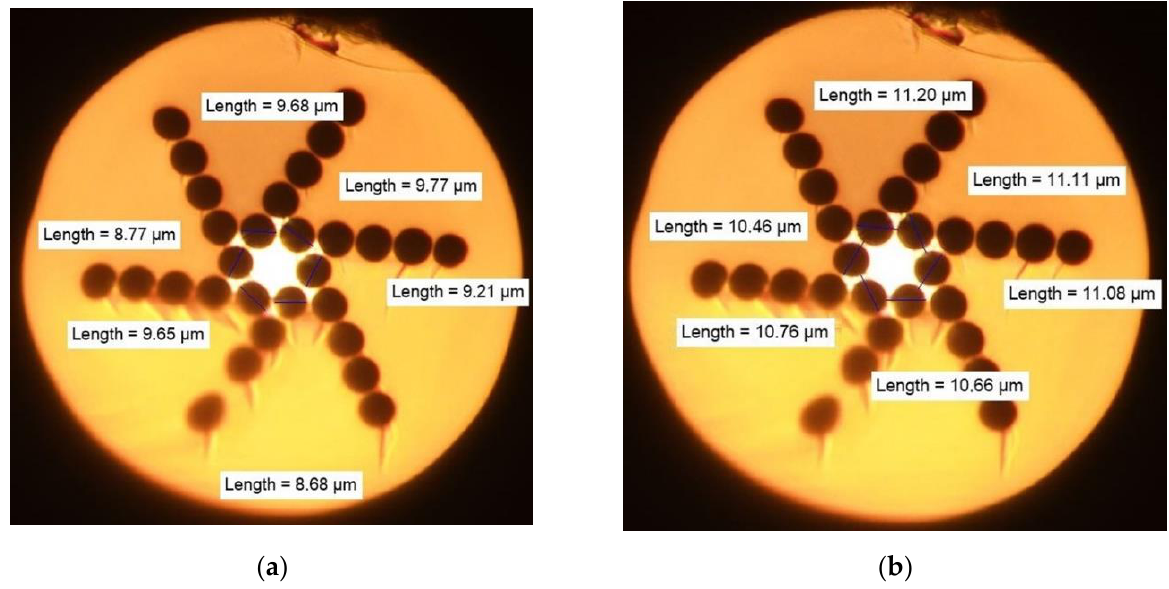
Figure 8. Dimensions of 2D-structure of the manufactured ESSR-MOF sample with chirality of 66 revolutions per meter: ( a )